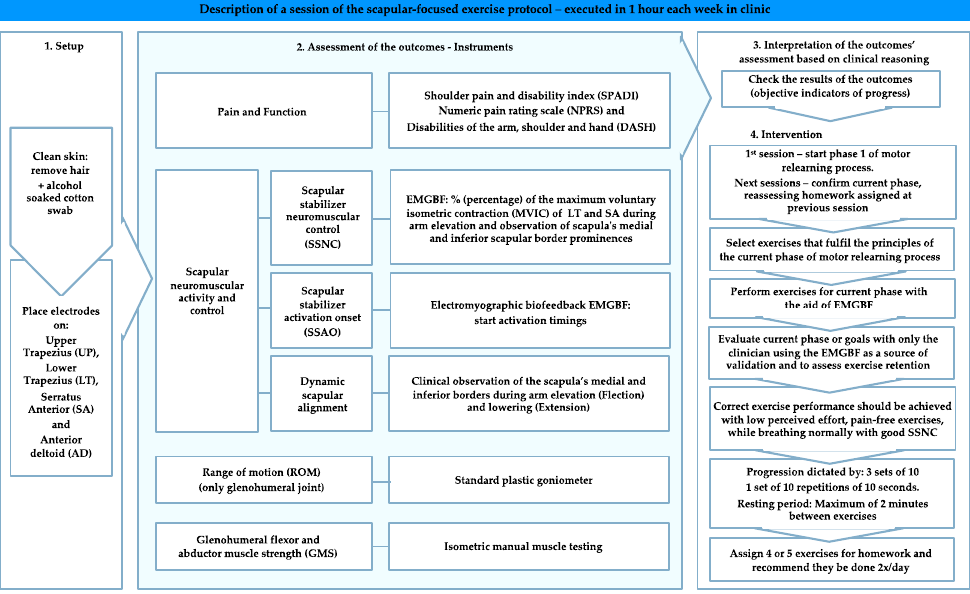
Figure 1. Resume of a session of the scapular-focused exercise protocol.